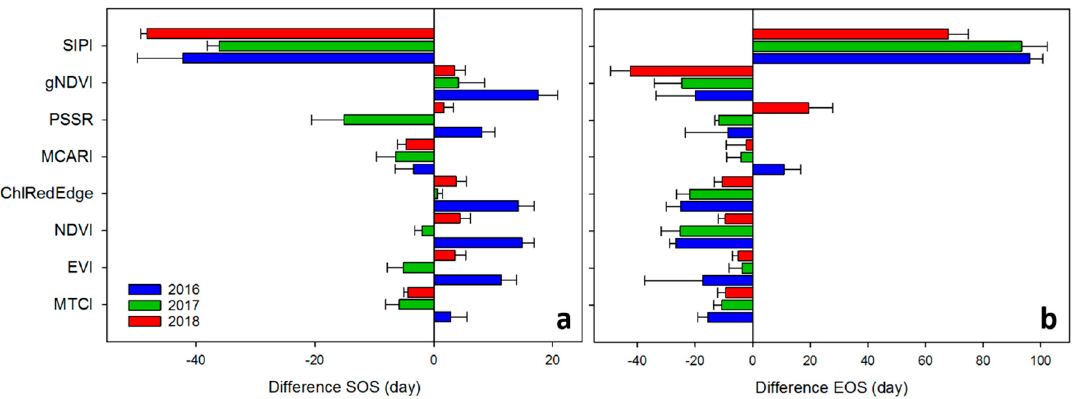
Figure 6. Difference, in days, between phonological metrics derived from Gross Primary Productivity (GPP) and VIs (see VIs definitions in Table 1) for each year averaged for filtering methods. ( a ) SOS—start of season; ( b ) EOS—end of season. Error bars represent the standard deviation between the filtering method estimates.